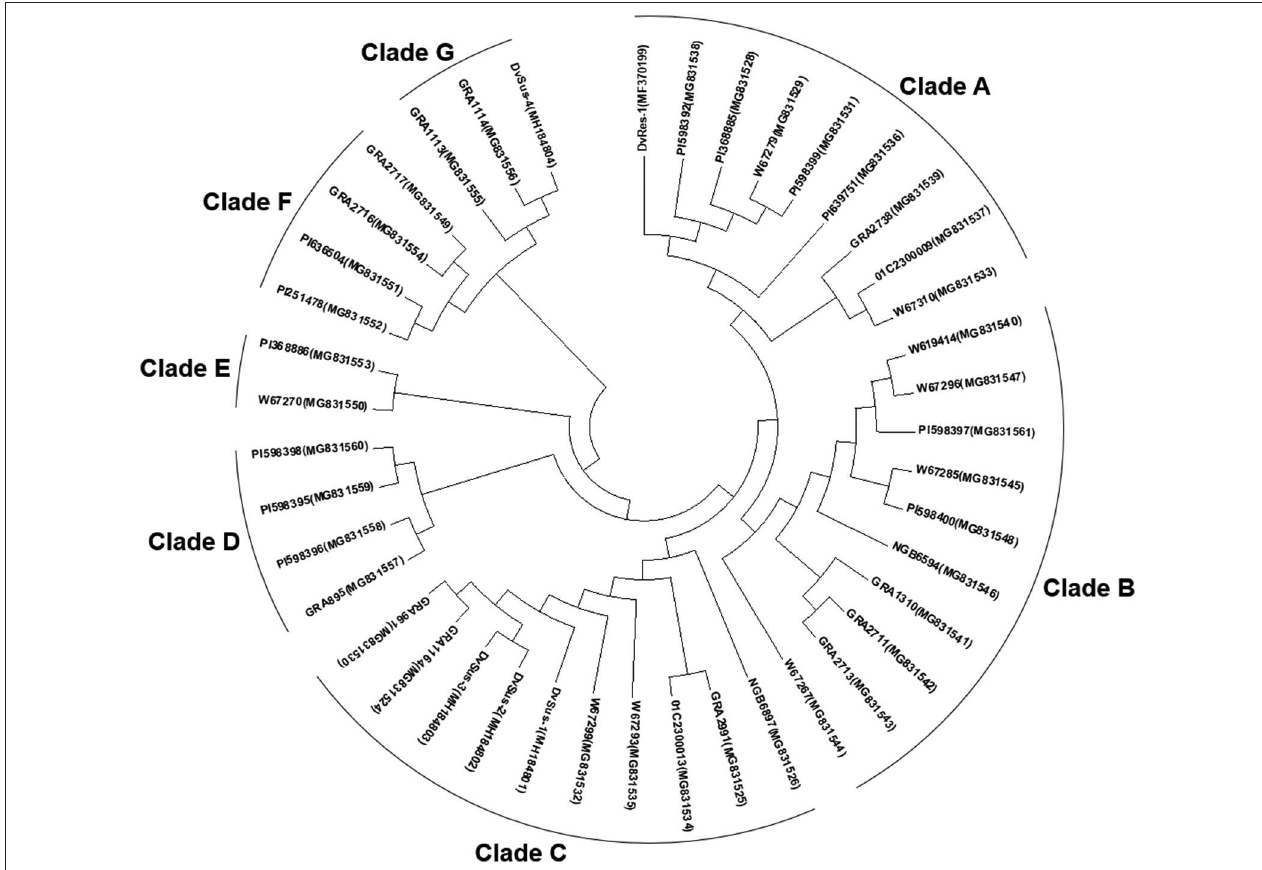
FIGURE 5 | Phylogenetic tree of Pm21 alleles constructed by the Neighbor-Joining method. The GenBank accession numbers are shown in brackets.